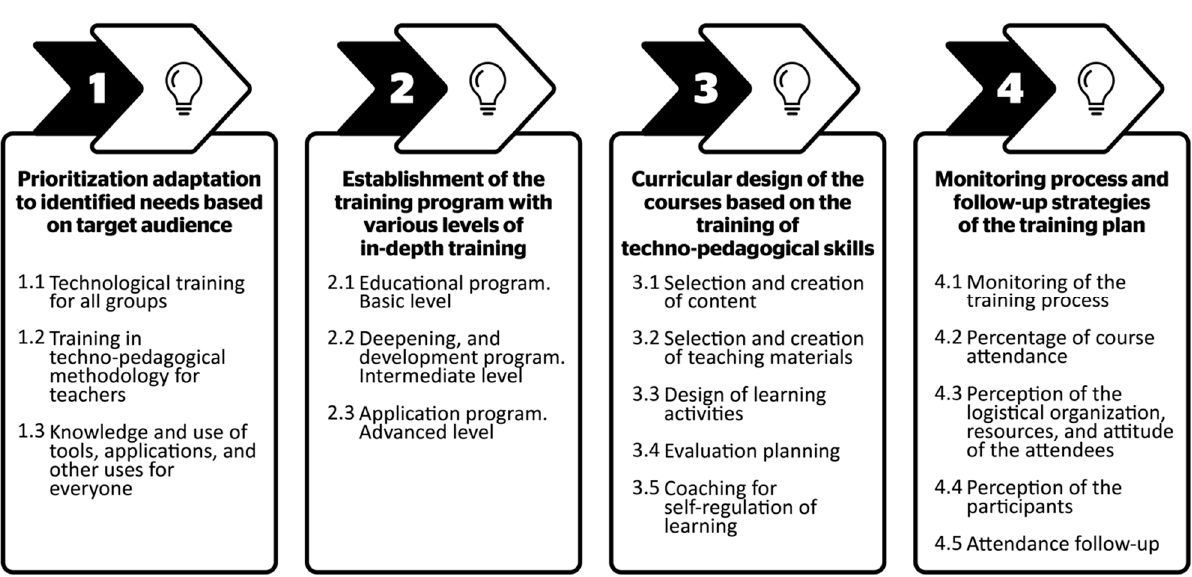
Table 1. Population sizes of the six universities.